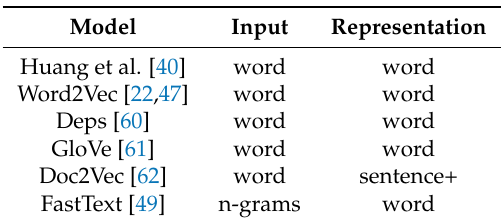
Figure 1. Word2Vec architecture. In addition to an input layer and an output layer, shallow architectures have a small number of hidden layers (one in this case). Table 1. The categorization of shallow models by input and representation level. All listed models are